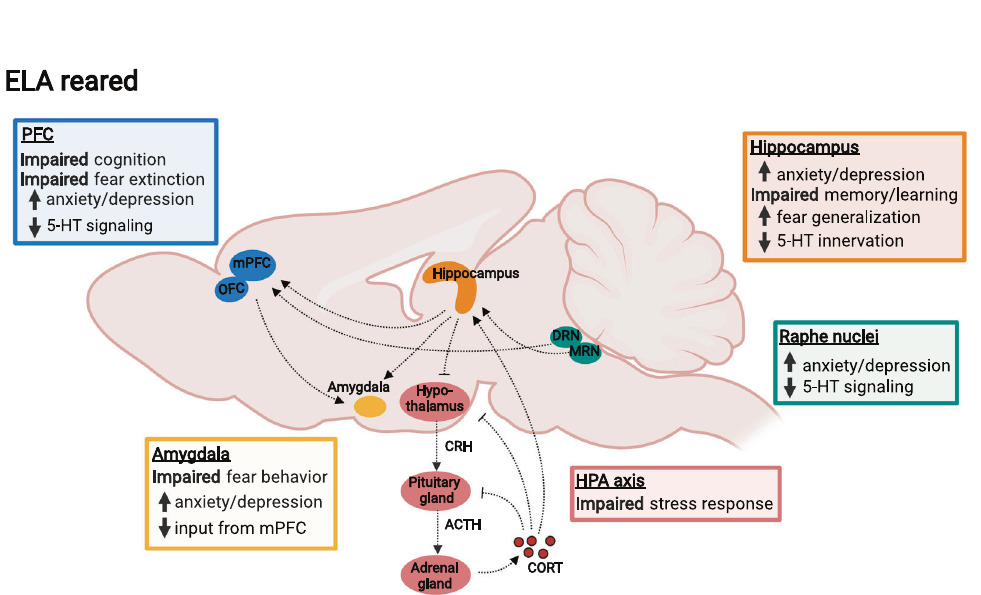
Fig. 3 ELA effects on neural circuitry. Shown are postnatal ELA effects on brain regions and neural circuits commonly implicated in psychopathology, such as the hippocampus, mPFC, OFC, amygdala, the HPA axis, and serotonergic signaling from the raphe nuclei (DRN and MRN) to cortical and limbic regions. Colored boxes denote ELA effects on speci fi c functions of each brain region related to cognition and affective